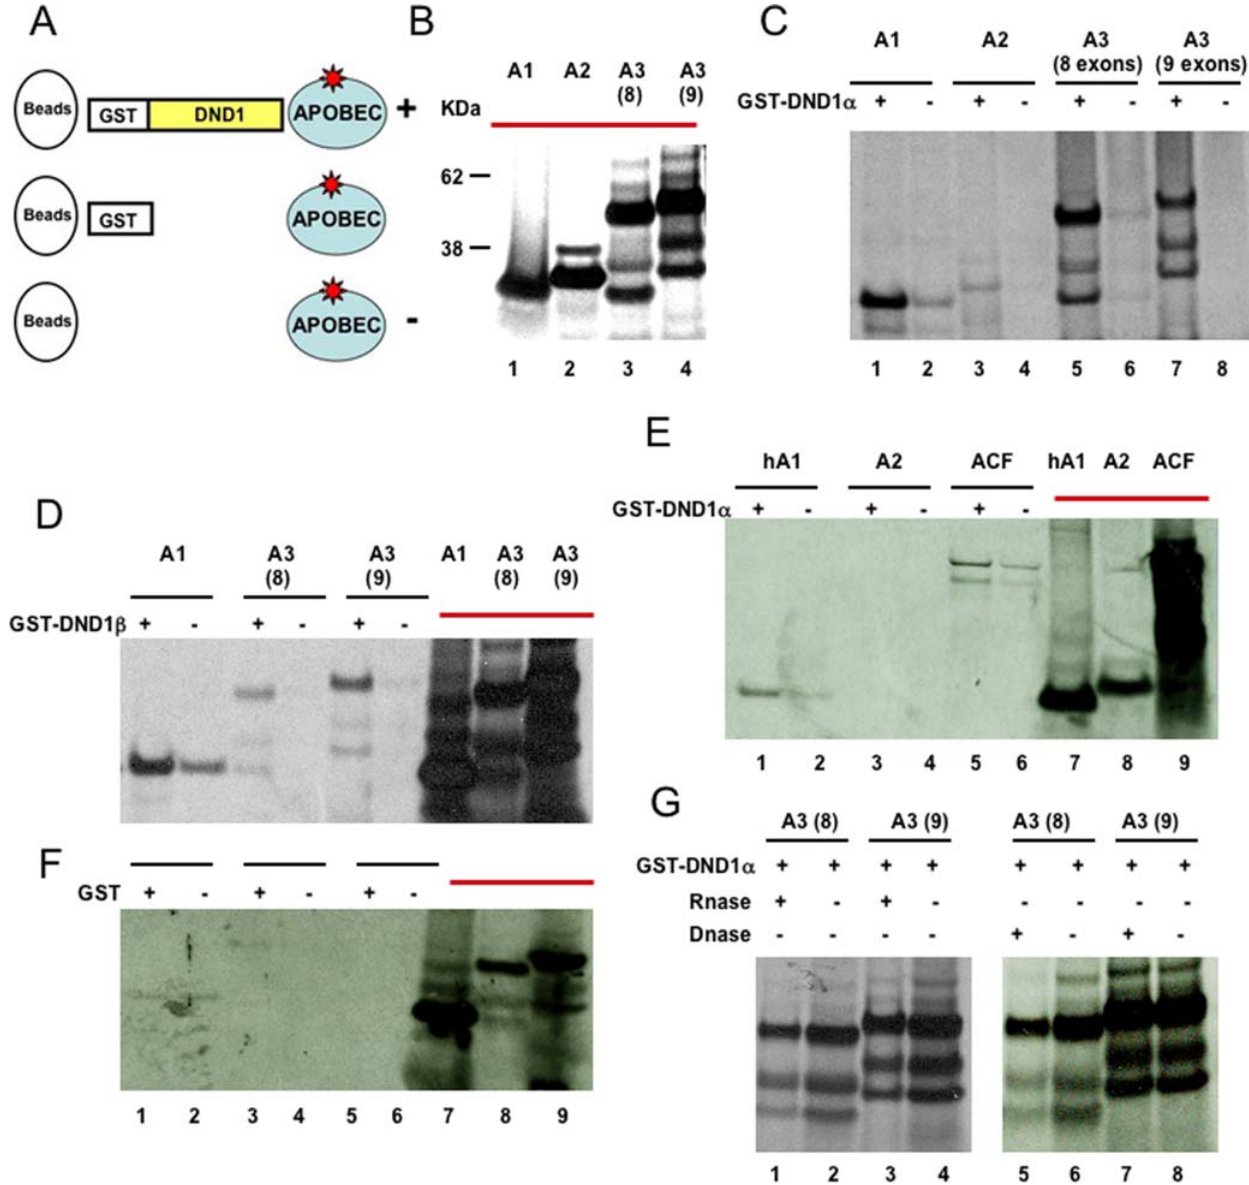
Figure 2. DND1 interacts with APOBEC3 invitro. ( a ) Experimental design to test interaction of DND1 to the APOBEC proteins invitro . All reactions contained [ 35 S]methionine-labeled APOBEC proteins (blue circles). The labeled proteins were incubated with purified GST-DND1 (indicated by + in panels c–e). Glutathione Sepharose 4B beads (beads, white circles) were added to the reactions. The beads are able to bind to the GST moiety of DND1 and should also ‘‘pull-down’’ proteins that associate with GST-DND1. Control incubations used beads alone incubated with labeled APOBEC proteins (indicated by–in panels c–e). ( b ) Invitro transcribed/translated [ 35 S]methionine-labeled APOBEC proteins. 5 m L was loaded from each translation reaction. A1 (APOBEC1), A2 (APOBEC2), A3 (8) (8-exon isoform APOBEC3) and A3 (9) (9-exon isoform of APOBEC3). The translated proteins used as input are marked with red bars (in panels b, d–f). ( c ) Binding of APOBEC proteins to GST-DND1 a . 40 m L of [ 35 S]methionine-labeled APOBEC proteins was incubated with GST beads and either with ( + ) or without ( 2 ) GST-DND1 a . Lanes 5 and 7 show binding of APOBEC3 to GST-DND1 a . Lanes 6 and 8 show no binding of APOBEC3 to the beads. ( d ) Binding of APOBEC proteins to GST-DND1 b . 40 m L of [ 35 S]methionine-labeled APOBEC proteins (APOBEC1 and both isoforms of APOBEC3) were incubated with GST beads and either with ( + ) or without ( 2 ) GST-DND1 b . Lanes 3 and 5 show binding of APOBEC3 to GST-DND1 b . Lanes 4 and 6 show no binding of APOBEC3 to the beads. Lanes, 7, 8 and 9 are the translated proteins used as input (5 m L). ( e ) Testing interaction of human APOBEC1 and ACF to GST-DND1 a . 40 m L of [ 35 S]methionine-labeled human APOBEC1 (hA1), mouse APOBEC2 (A2) and human ACF were incubated with GST beads and either with ( + ) or without ( 2 ) GST-DND1 a . Comparison of lanes 1 and 2 indicate weak binding of human APOBEC1 (hA1) to GST-DND1 a . Comparison of lanes 5 and 6 indicate no specific binding of ACF to GST-DND1 a . Lanes, 7, 8 and 9 are the translated proteins used as input (5 m L). ( f ) Binding of APOBEC proteins to GST (second control) . 40 m L of [ 35 S]methionine-labeled APOBEC proteins (APOBEC1 and both isoforms of APOBEC3) were incubated with GST beads and either with ( + ) or without ( 2 ) GST. Lanes, 7, 8 and 9 are the translated proteins used as input (5 m L). ( g ) Effect of RNase (left) and DNase (right) on APOBEC3 and GST-DND1 interaction . [ 35 S]methionine-labeled APOBEC proteins incubated together with GST-DND1 a˜ and GST beads were divided into two. Each aliquot was treated with RNase ( + ) or DNAse ( + ) or not treated ( 2 ) prior to electrophoresis.